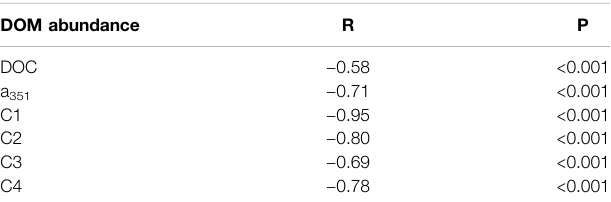
TABLE 3 | Summary of correlations between salinity and DOM abundance in Jiaozhou